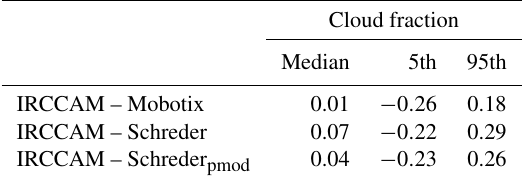
Table 2. Median and 5th and 95th percentiles of the differences in calculated cloud fractions between IRCCAM and the visible all-sky cameras. The numbers are in the range